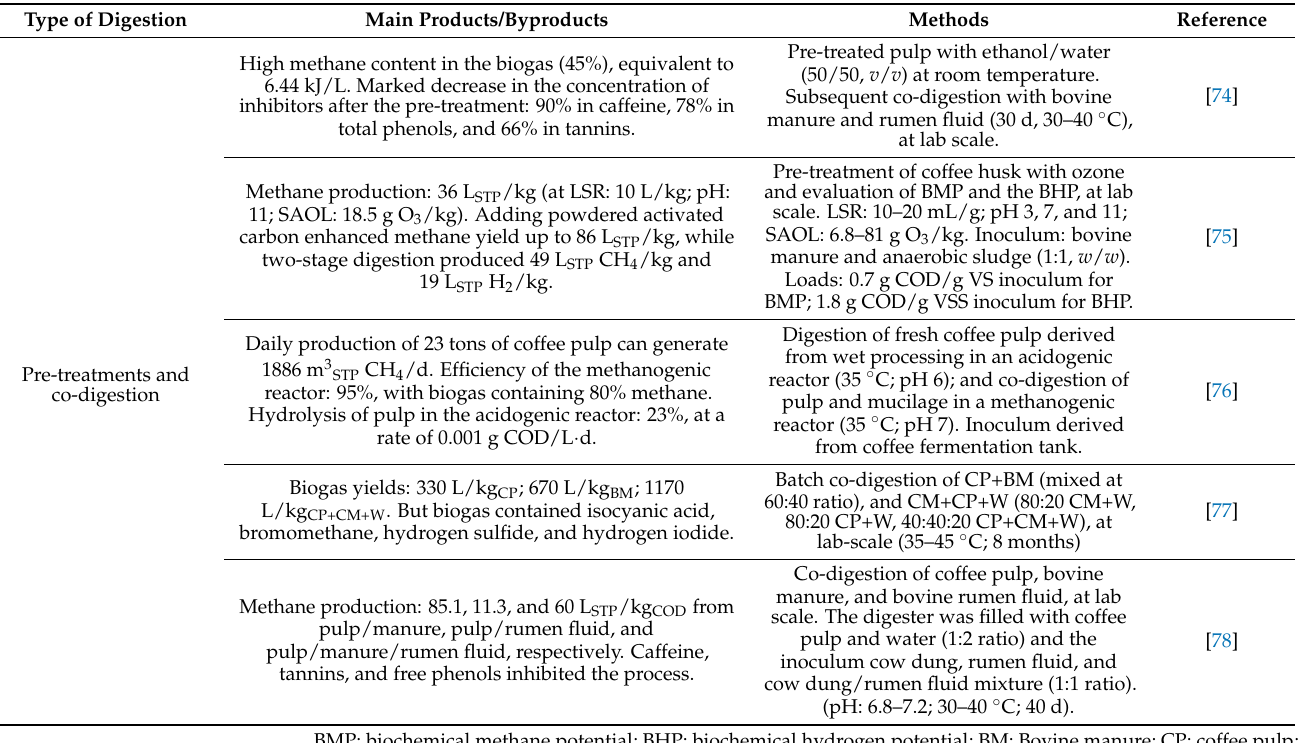
Table 4. Biomethanization of wastes and by-products derived from primary coffee processing. Type of Digestion Main Products/Byproducts Methods Reference